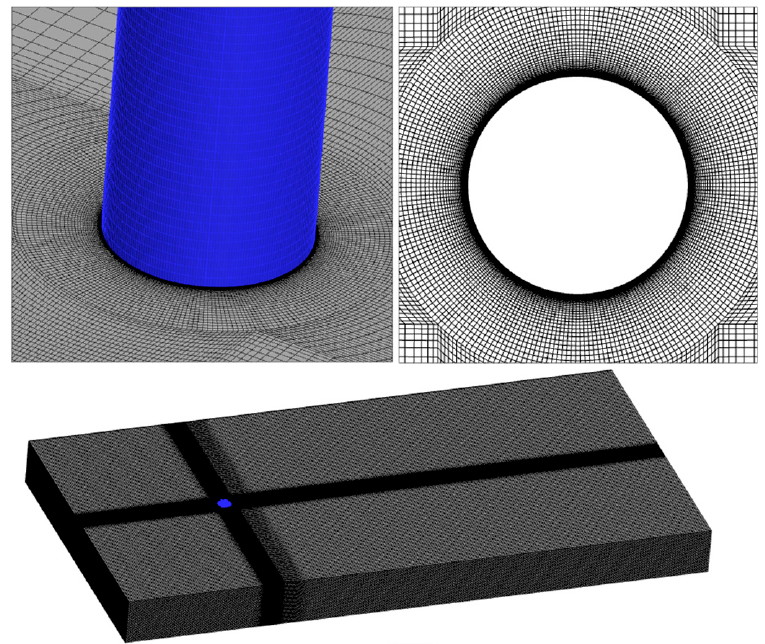
Figure 2. Computational mesh for the circular cylinder.